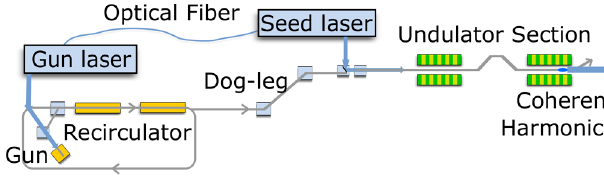
FIG. 2. Layout of the CHG-FEL test setup at MAX-lab, in- cluding electron accelerator, undulator section, the seed laser beam line, as well as the laser synchronization scheme.